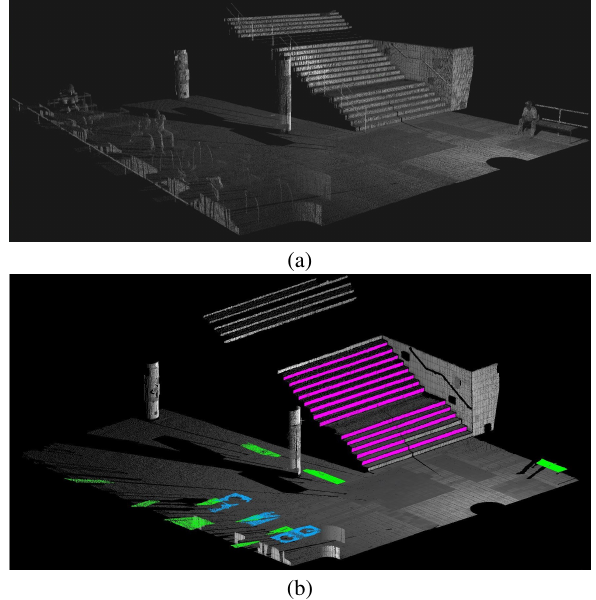
Figure 4: Point cloud of an auditorium. (a) Original scene. (b) Stairs were identified by vertical width of the segment and are highlighted in pink whilst tables and benches are coloured blue and green